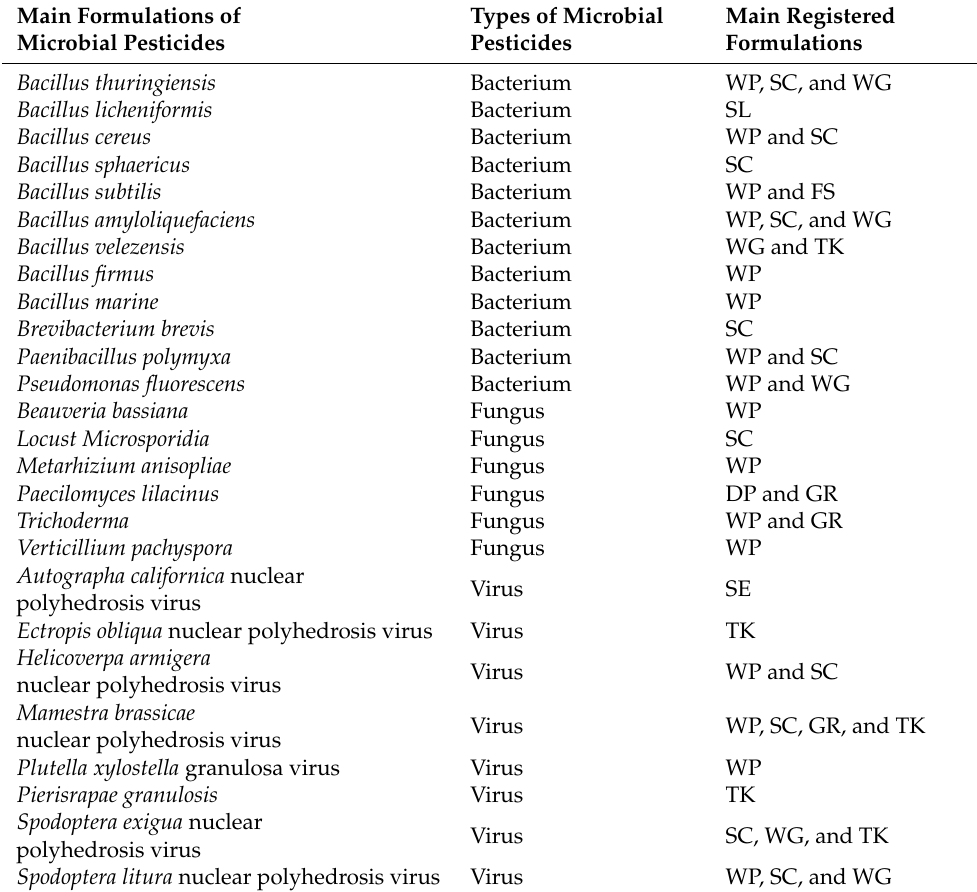
Table 1. Main formulations of microbial pesticides.